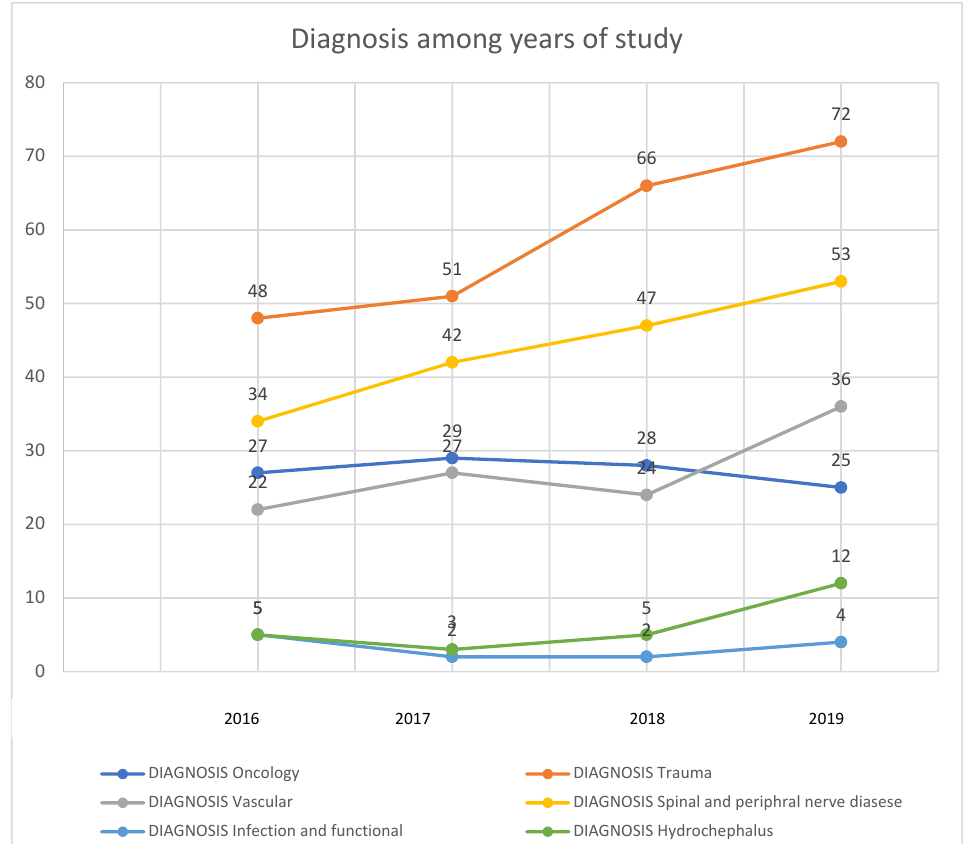
Figure 1. Total number of admitted patients in each year with the corresponding diagnostic category.